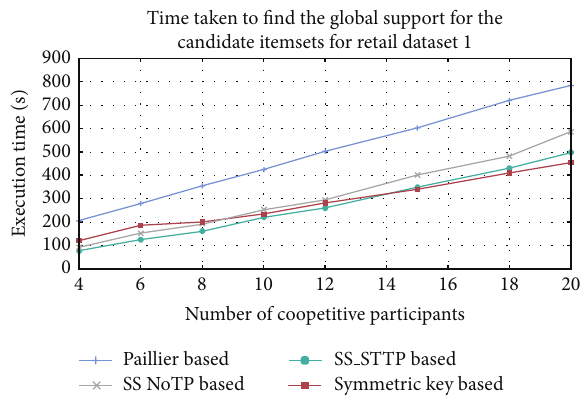
Figure 4: Graph showing the execution time for secure sum to find globally frequent itemsets for dataset